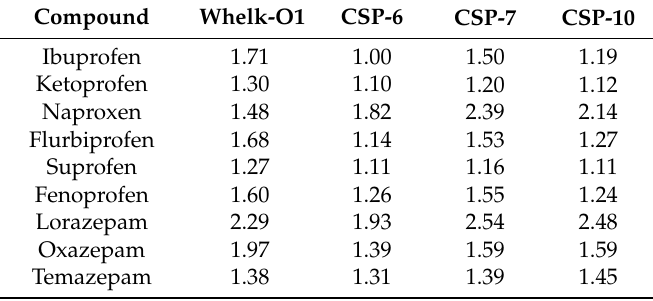
Table 1. Comparison of the separation factors ( α ) of tested pharmaceutical drugs obtained on CSP-6 , CSP-7 , CSP-10 and Whelk-O1 1 .